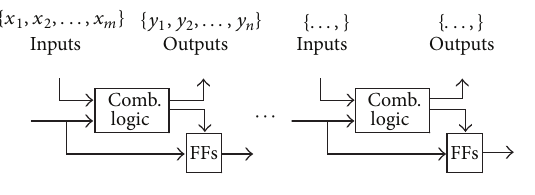
Figure 1: Symbolic simulation